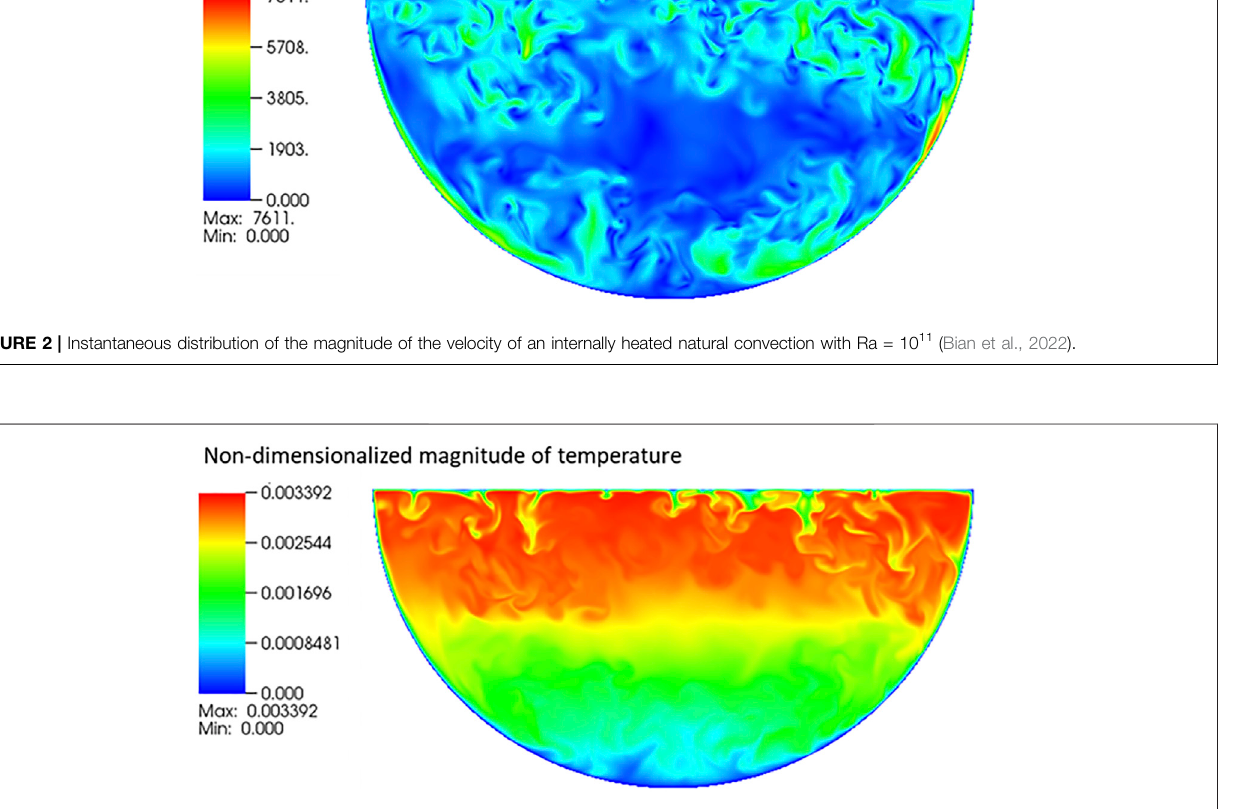
FIGURE 3 | Instantaneous temperature distribution of an internally heated natural convection with Ra = 10 11 (Bian et al.,